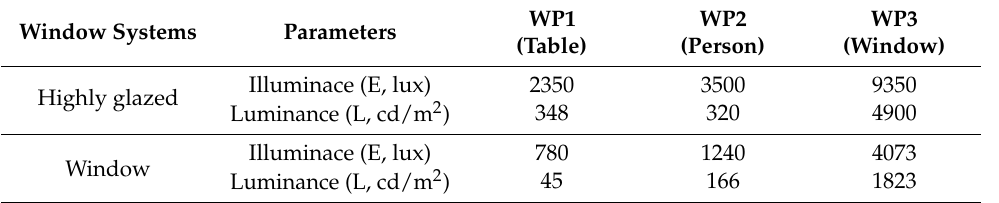
Table 1. This is a table. Incoming illuminance and luminance data of real pictures. Window